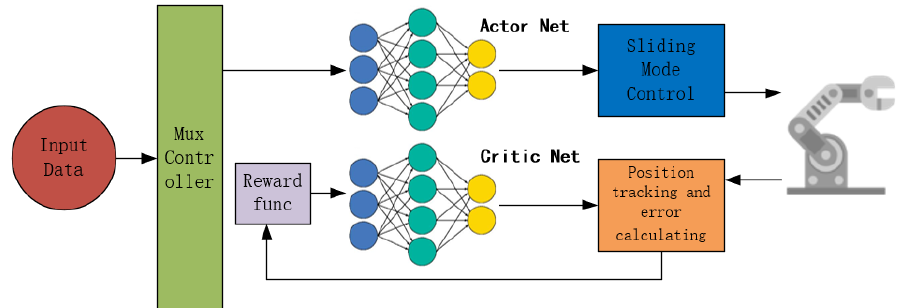
Figure 2. DDPG–NNFTSMC control flow chart.